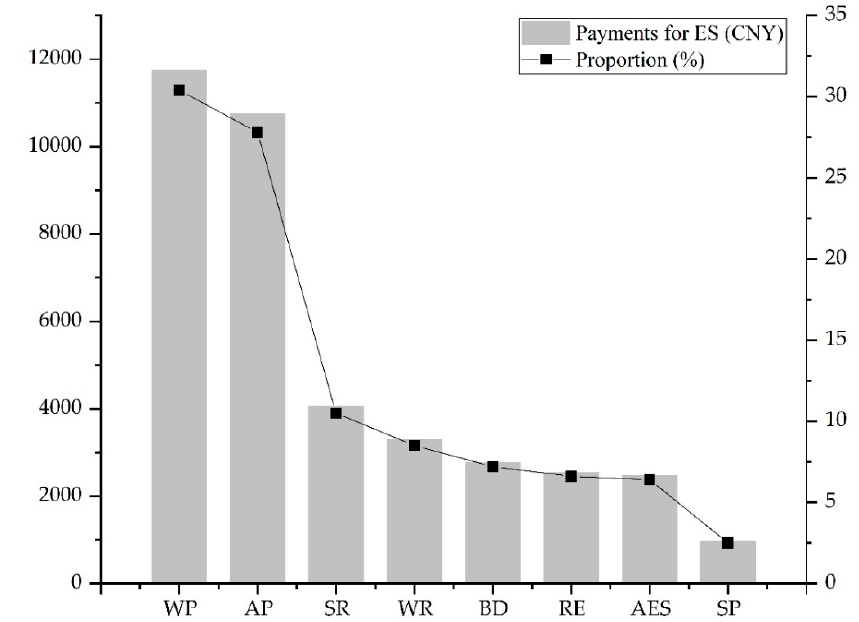
Figure 4. Total amount and number of people willing to pay for ecosystem services.